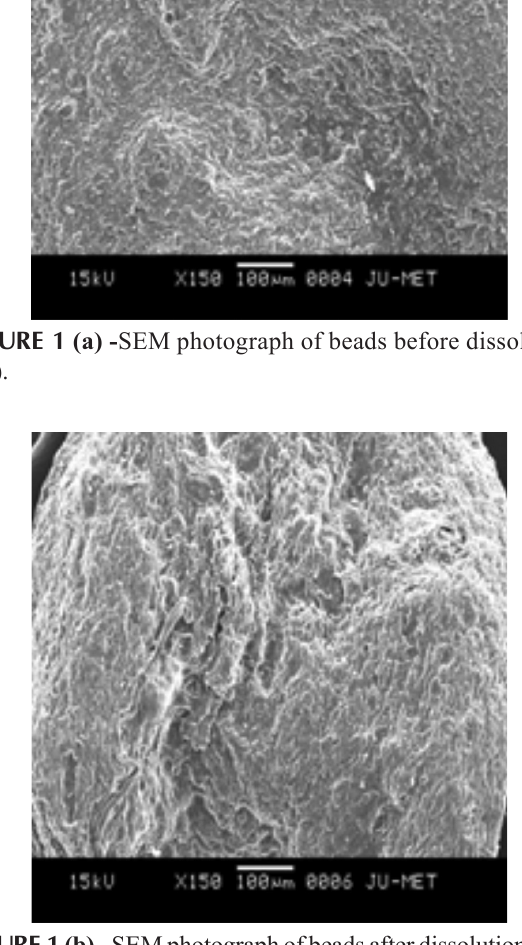
FIGURE 1 (b) - SEM photograph of beads after dissolution (F3).